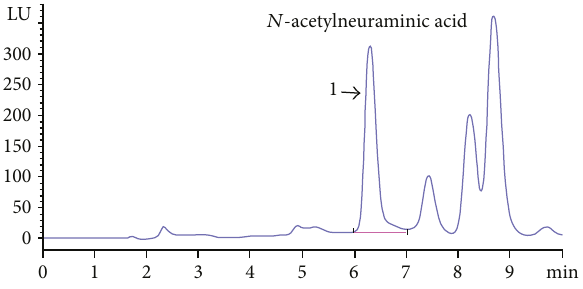
Figure 1: Analytical HPLC chromatogram of sialic acid in EBN. Peak 1 stands for N -acetylneuraminic acid compound of sialic